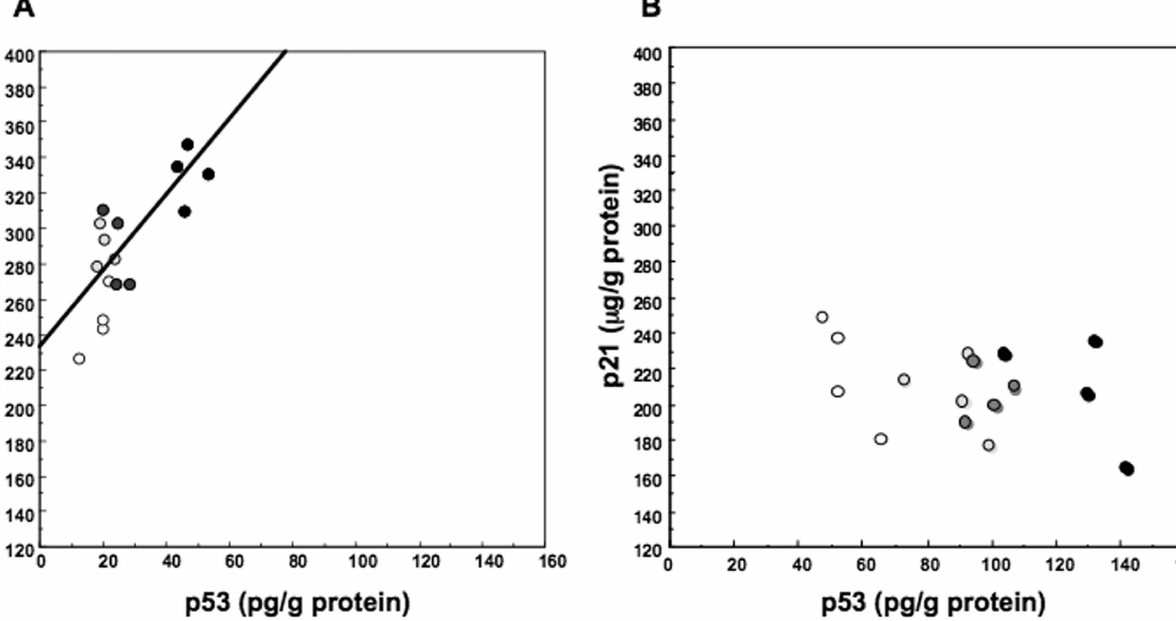
Figure 5. Cellular p53 and p21 levels in hepatocytes treated with HGF. Rat hepatocytes were cultured in WE containing 10% FCS and various concentrations of HGF for 18 hours. Open circles denote hepatocytes cultured in the absence of HGF. Dotted open circles denote hepatocytes cultured with 2.5 ng/mL HGF. Dotted closed circles denote hepatocytes cultured with 5 ng/mL HGF. Closed circles denote hepatocytes cultured with 10 ng/mL HGF. (A) Hepatocytes cultured at high density. (B) Hepatocytes cultured at low density.